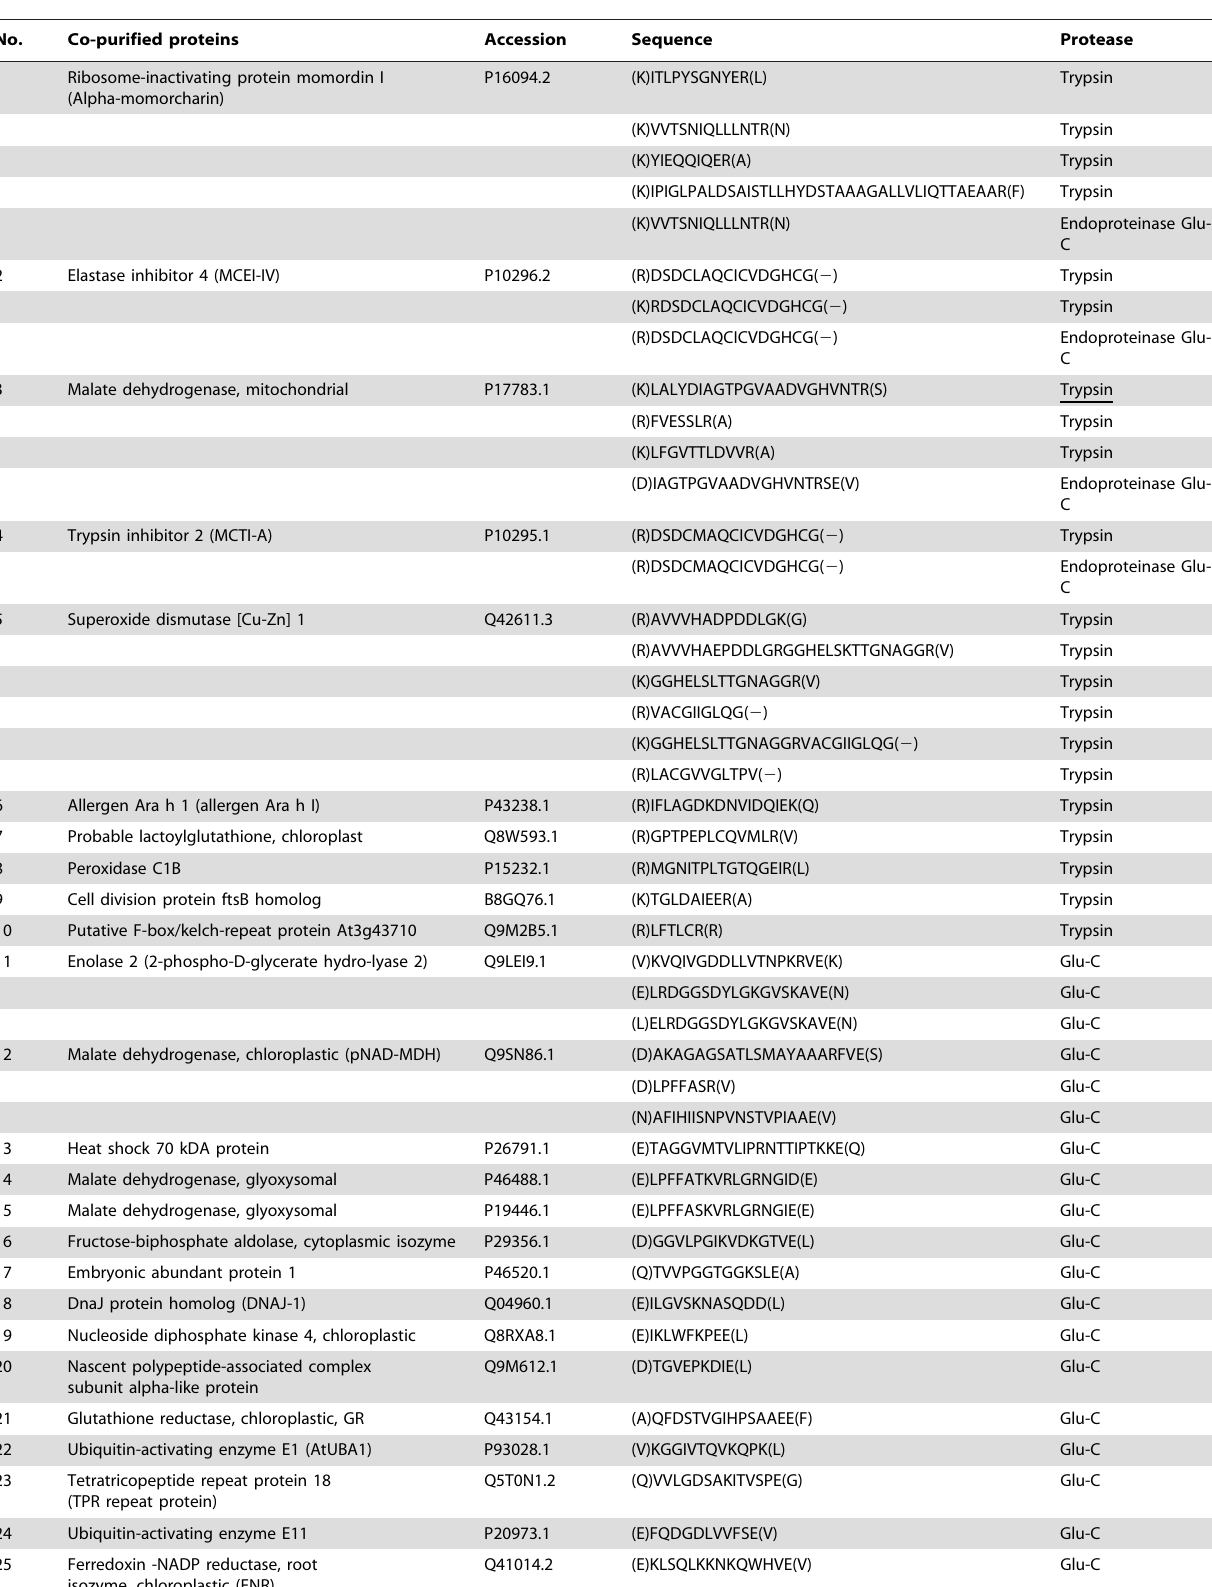
Table 2. LC/MS/MS analysis of PAP-copurified proteins from bitter melon